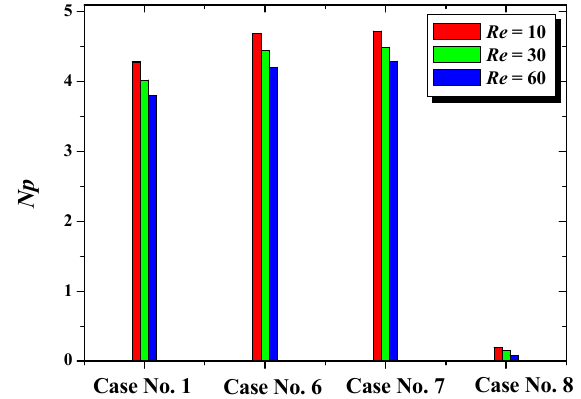
Figure 9. Power number for different cases.